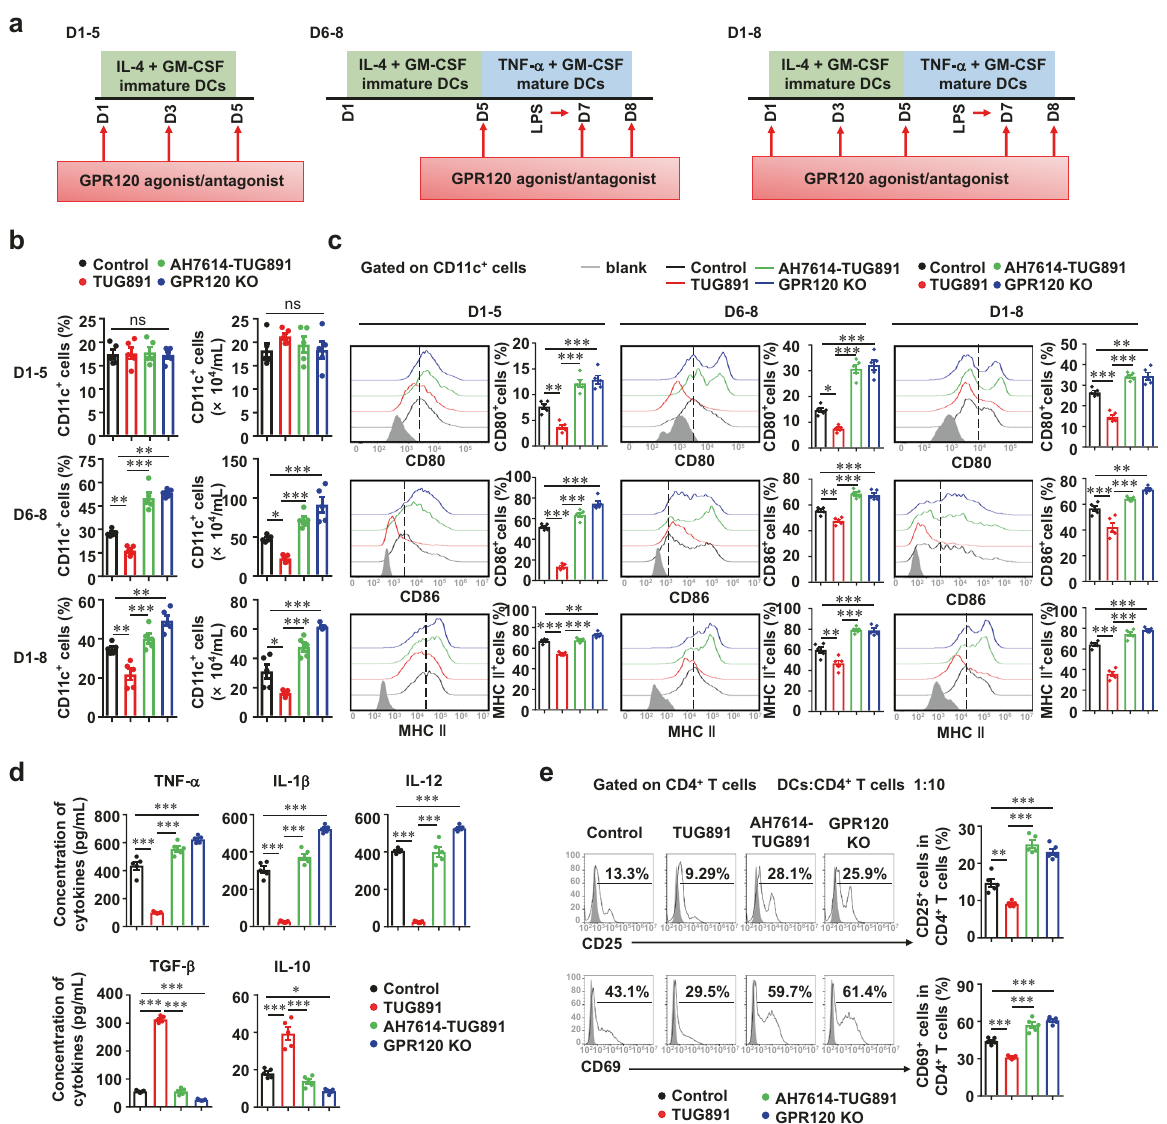
Fig. 5 GPR120 induced the generation of regulatory DCs. a Schema of the induction of DC maturation with GPR120 agonist or antagonist treatment in vitro. BMCs from wild-type (WT) mice were isolated and incubated with GM-CSF (10 ng/mL) plus IL-4 (5 ng/mL) for 5 days, and GM-CSF (10 ng/mL) plus TNF- α (50 ng/mL) for three additional days. LPS (0.1 μ g/mL) was added on day 7. Cells were stimulated with TUG891 (20 μ M) with or without AH7614 (20 μ M) pretreatment on days 1 – 5, days 6 – 8, or days 1 – 8. b The percentages and numbers of CD11c + DCs were analyzed by fl ow cytometry on day 5 and day 8. c Cells were stained for CD11c, CD80, CD86, and MHC II and analyzed by fl ow cytometry on day 5 and day 8. d The levels of TNF- α , IL-1 β , IL-12, TGF- β , and IL-10 were measured by enzyme-linked immunosorbent assay. e CD4 + T cells (5 × 10 5 cells/well) from the spleens of WT BALB/c mice were cocultured with WT DCs or GPR120 − / − DCs (0.5 × 10 5 cells/well) from C57BL/6 mice. WT DCs were treated with TUG891 (20 μ M) with or without AH7614 (20 μ M) pretreatment. The expression of CD25 and CD69 on CD4